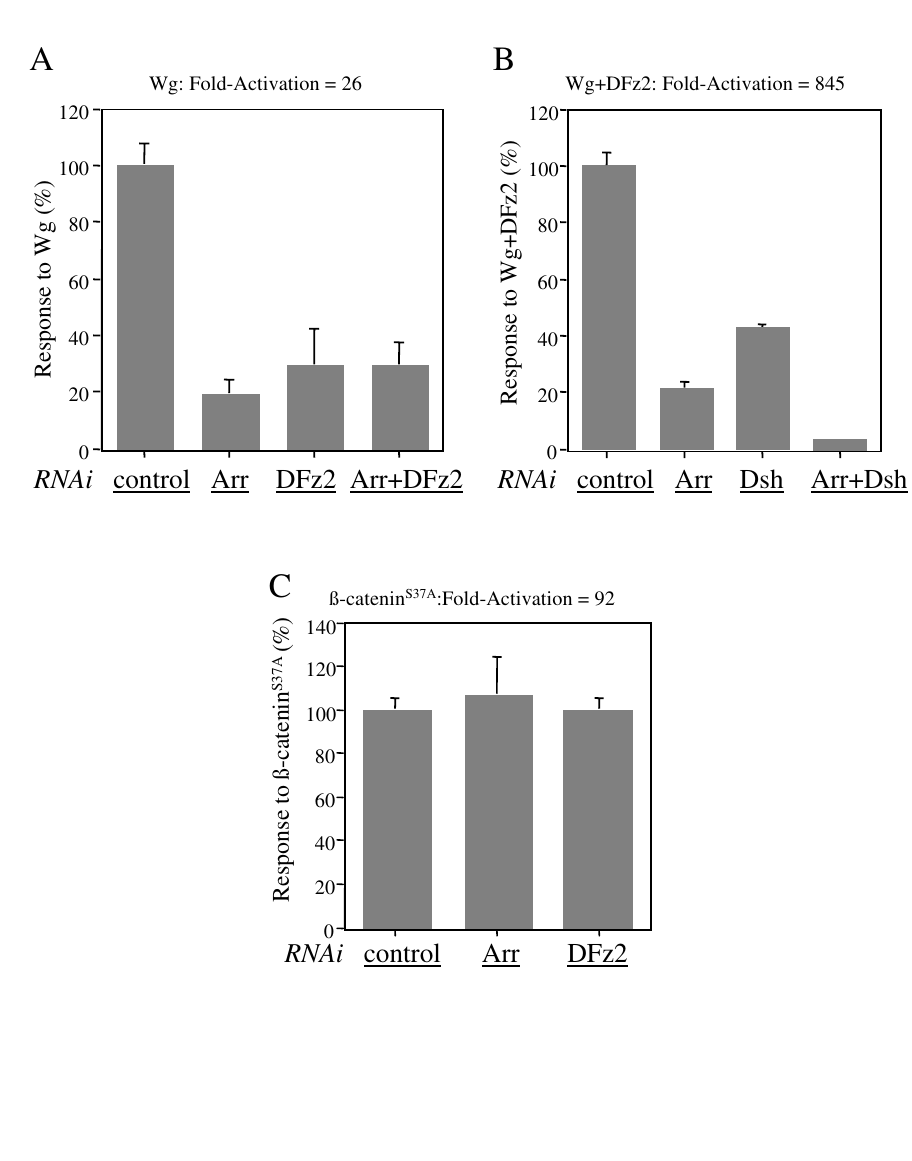
Wg signaling activity is impaired with the loss of either Arr or DFz2 function by dsRNA interference. S2 cells were treated with the following dsRNAs: Aco as a control (A-C), Arr (A-C), DFz2 (A, C), and Dsh (B). The next day, cells were transfected with the following expression plasmids: Wg (A), Wg and DFz2 (B) and β -catenin S37A (C) together with the reporters. The level of fold activation was set to 100% for cells treated with control dsRNAi, and the actual value is indicated above the figures. The responses of the transfected S2 cells treated with different dsRNAs are based on the percentage of fold activation compared with the control. All experiments were done in triplicate; error bars represent standard